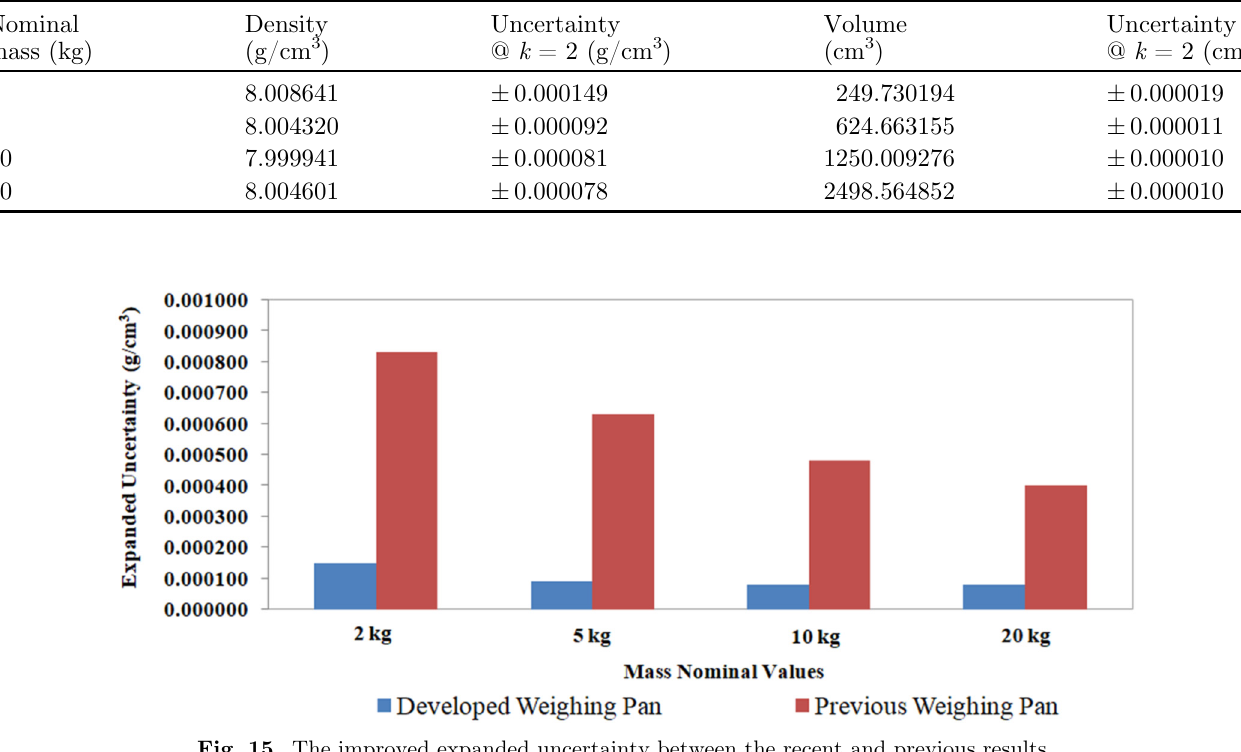
Fig. 15. The improved expanded uncertainty between the recent and previous